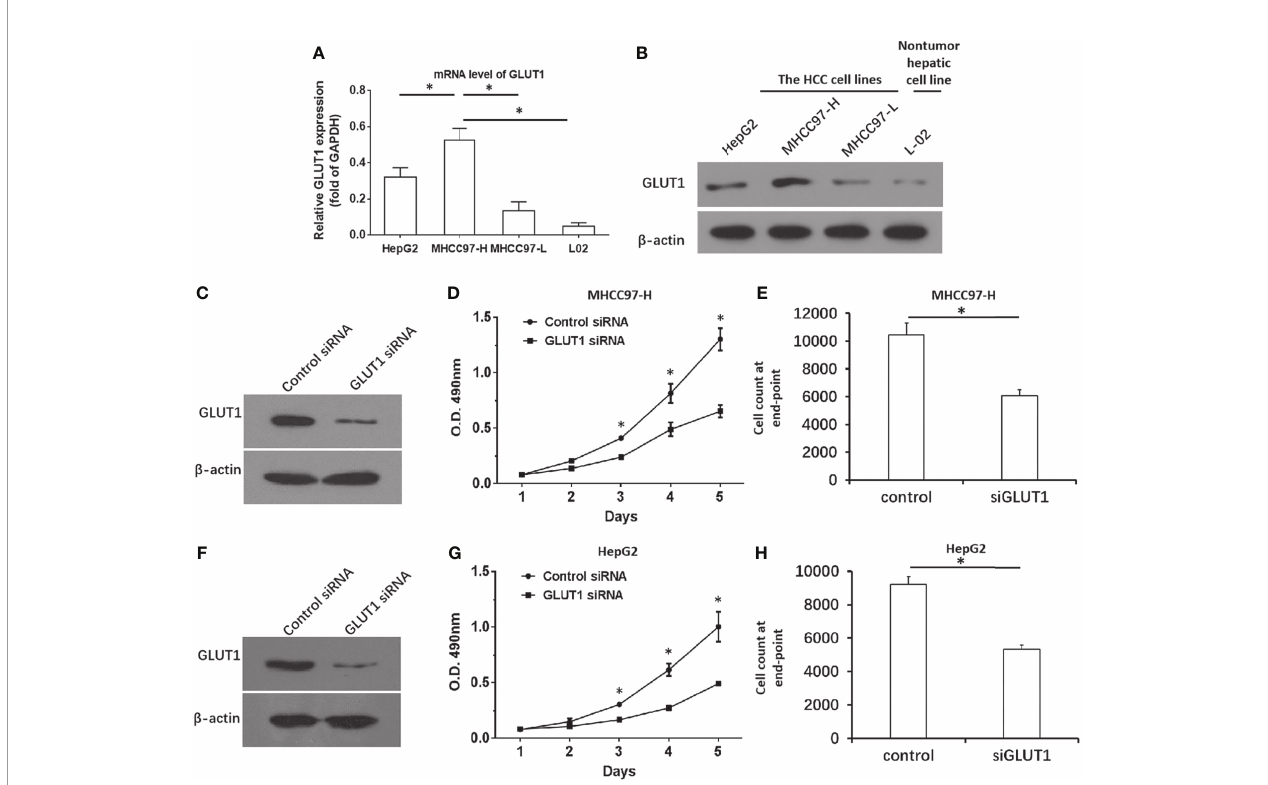
FIGURE 2 | GLUT1 is a positive regulator of HCC cells. (A, B) The endogenous expression of GLUT1 in the hepatic cell lines was examined by qPCR (A) and western blot (B) . The results were shown as a histogram (A) and images of western bolt (B) . The MHCC97-H (C – E) or HepG2 (F – H) cells were transfected with control or siGLUT1. The protein levels of GLUT1 was examined by western blot and shown in (C, F) , while the proliferation of HCC cells was examined by the MTT and shown as the line chart in panels (D, G) The cell number at the end point was shown (E, H) .